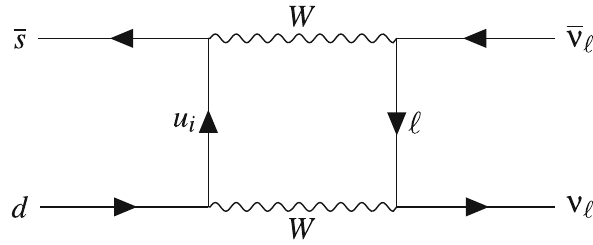
Fig. 8 Box diagram contributing to K L → π 0 νν and K + → π + νν , from which X ( x i ) in Eq. (71) is obtained, with u i , j = u , c , t , T and (cid:20) = e ,μ,τ